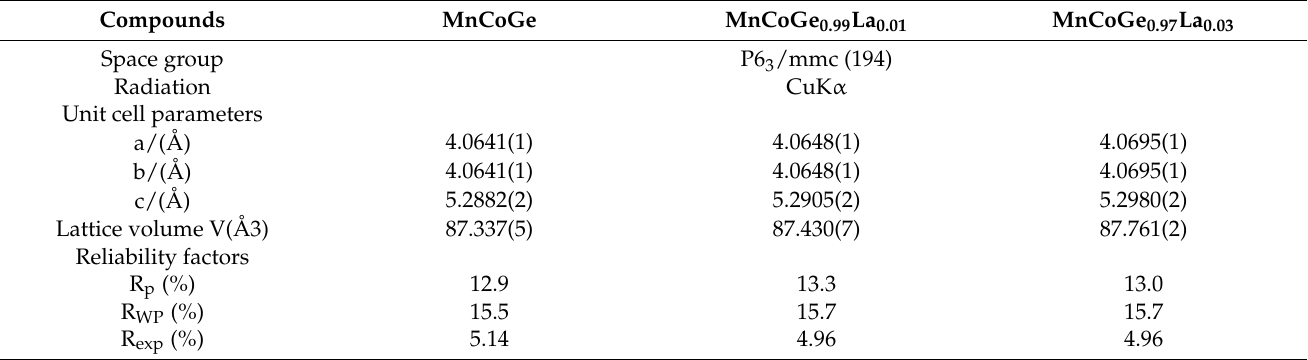
Table 1. Rietveld refinement result for MnCoGe 1 ‐ x La x series alloy.